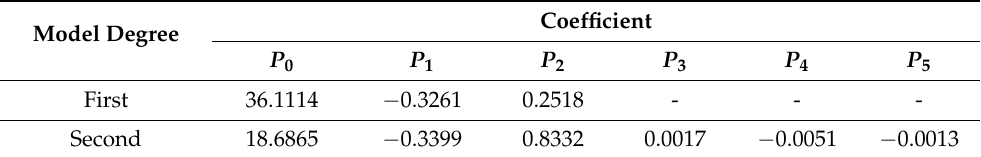
Figure 8. TPMC values ’ 3D surface plots by the first- and second-degree models: ( a ) First-degree model; ( b ) Second-degree model.